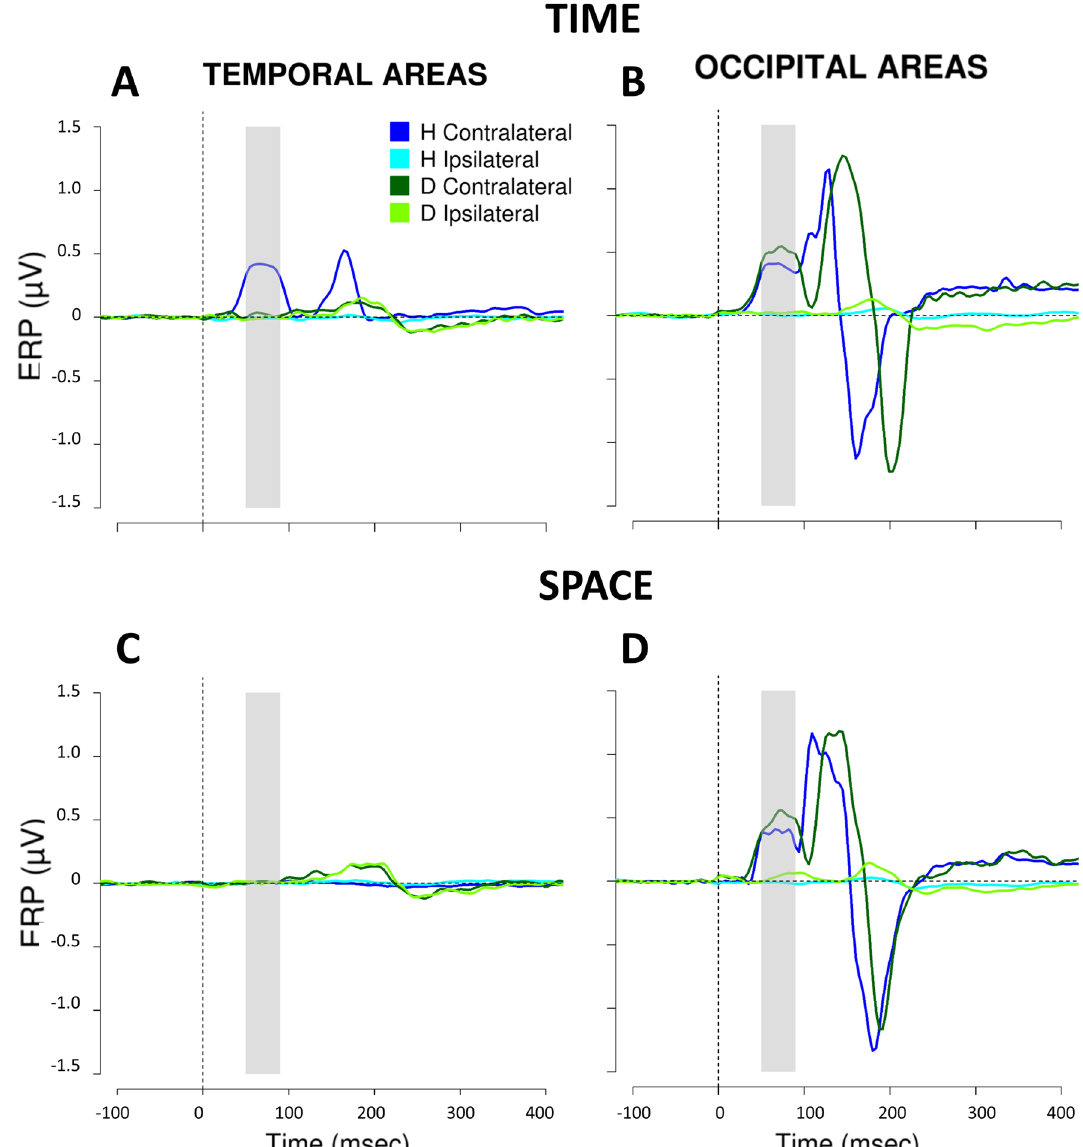
Figure 5. ERPs elicited by S2 during the time- (top) and space- (bottom) bisection tasks in temporal (left) and occipital (right) areas. ERPs collapsed over temporal (i.e., T7/T8)/occipital (i.e., O1/O2) scalp sites contralateral to the spatial side of S2 presentation are in dark blue and dark green for hearing and deaf groups respectively. ERPs collapsed over temporal/occipital scalp sites ipsilateral to the spatial side of S2 presentation are in cyan and light green for hearing and deaf groups respectively. On the x-axis, t = 0 is stimulus onset. The shaded area delimits the selected time window (50–90